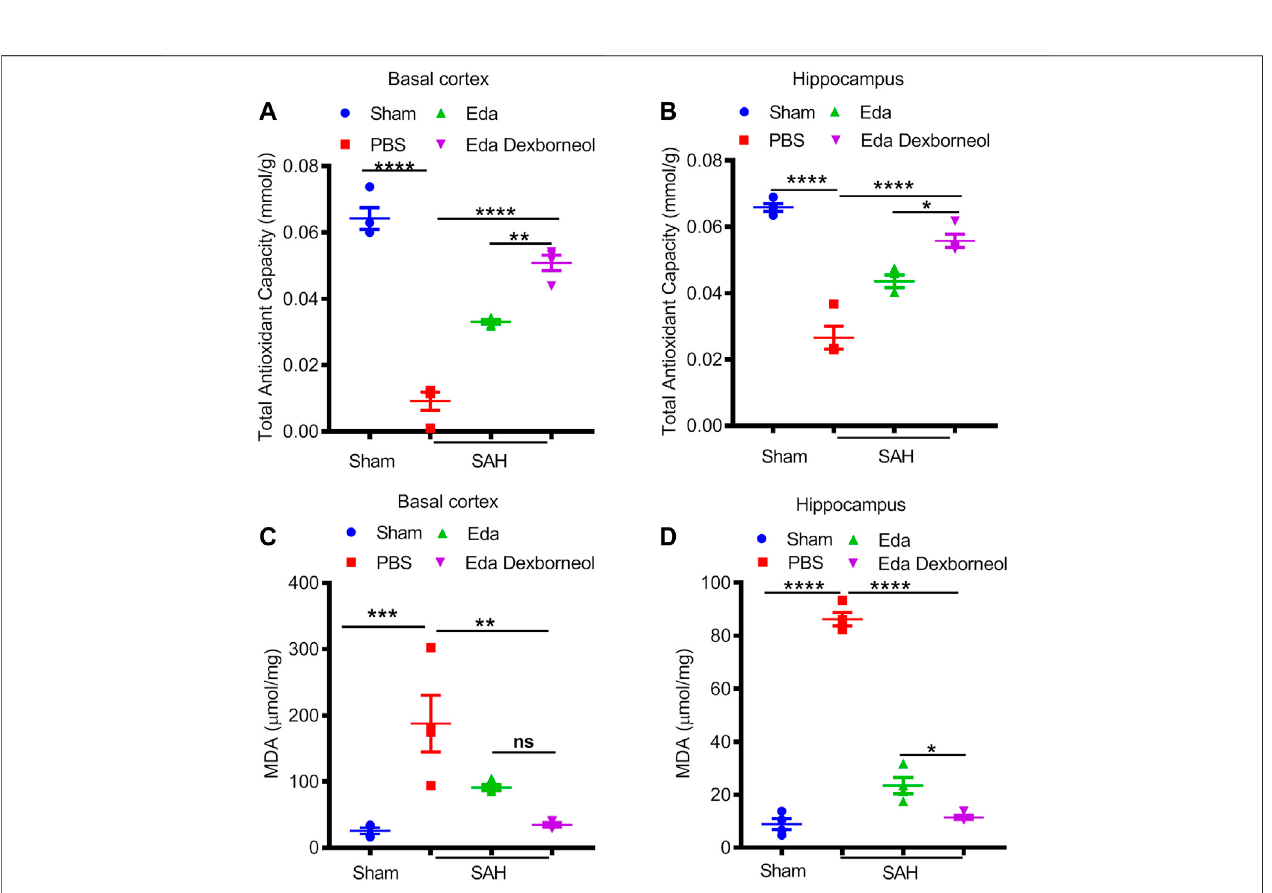
FIGURE5| Edaravonedexborneoltreatmentsigni fi cantlysuppressedoxidativestressafterSAH.ABTSassaywasusedtodetectthetotalantioxidant capabilityof cortical (A) andhippocampaltissues (B) afterSAH.AnMDAassaywasusedtoevaluateSAH-inducedlipidperoxidationinthecortex (C) andhippocampus (D) .Dataare given as mean ± SEM. * p < 0.05, ** p < 0.01, *** p < 0.001, **** p < 0.0001. Eda: edaravone; Eda dexborneol: edaravone dexborneol.